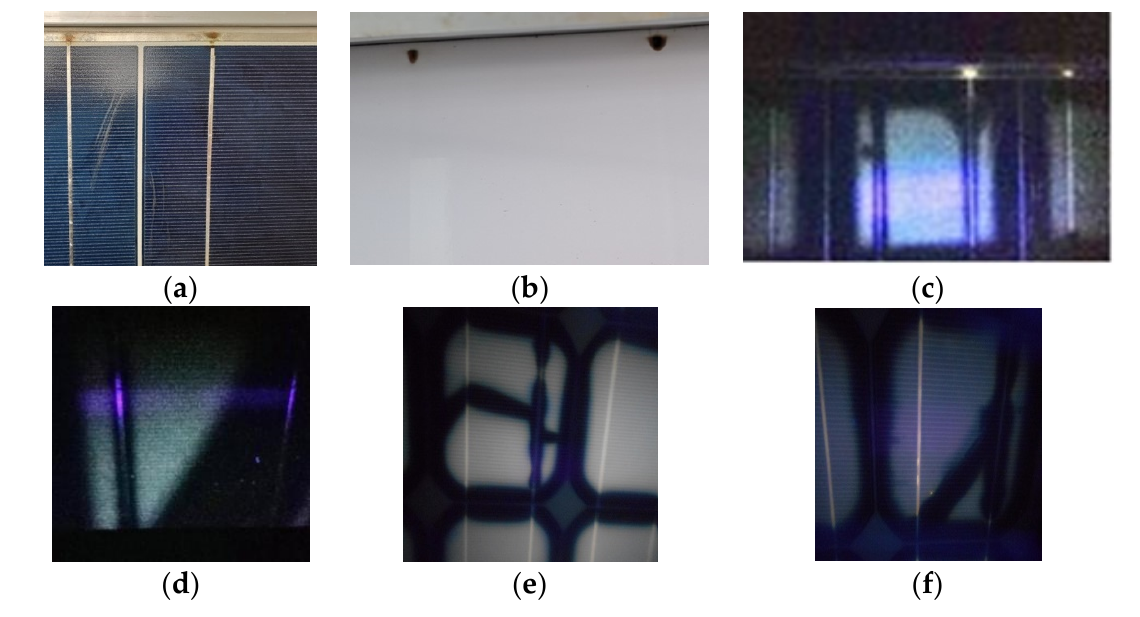
Figure 6. ( a ) Digital image of the front and ( b ) back side of the large pc-Si ODT no1 showing 2 corrosion signs. ( c ) The UVF image clearly shows both corrosion signs and suppression of the UV fluorescence in the cell edges and the busbar. ( d ) Diagonal UV fluorescence pattern, ( e , f ) UVF im- ages of a SW80 module showing invisible cracks. UVF images captured during PV illumination with UV light at 375 nm.